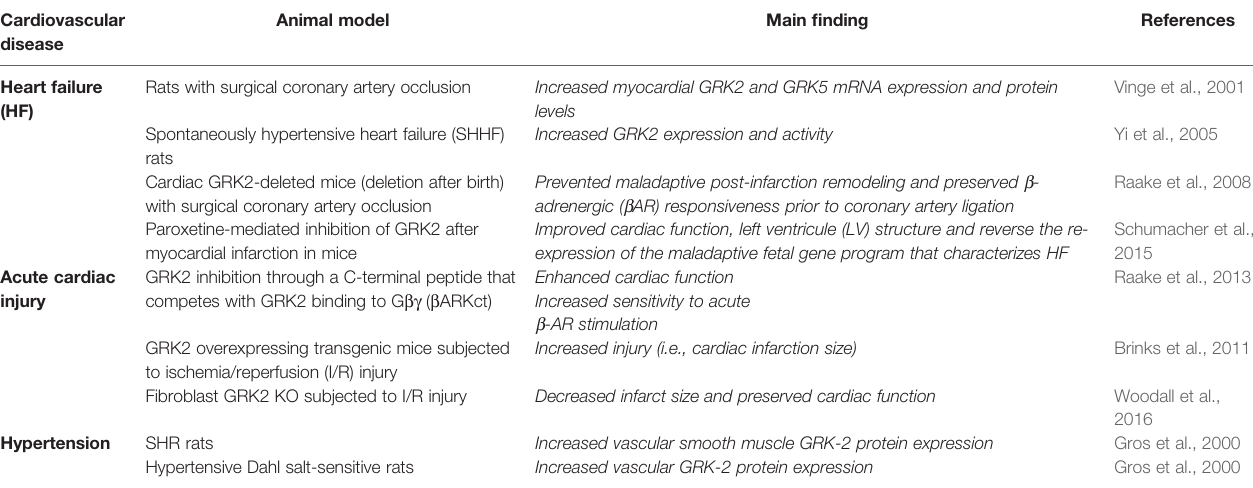
TABLE 3 | GRK alterations in animal models of cardiovascular disease.